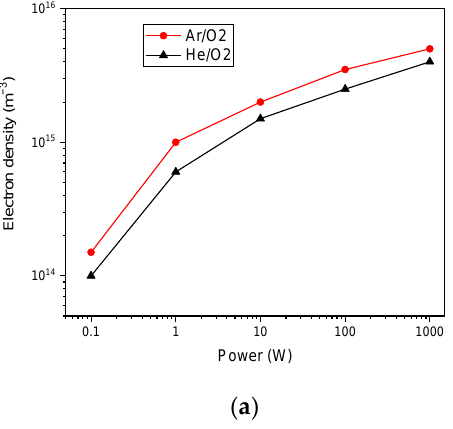
Figure 13. ( a ) Density and ( b ) electron temperature as a function of input power in Ar/O 2 and He/O 2 at (20%) O 2 and (0.3 Torr) pressure.